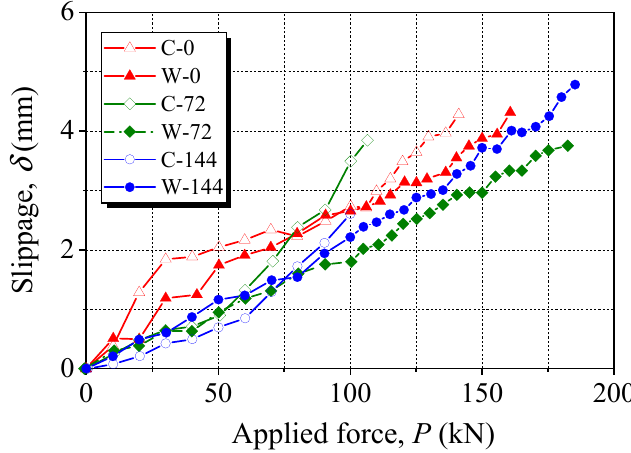
Figure 11. Slippage of anchored CFRP laminates during tensile tests.